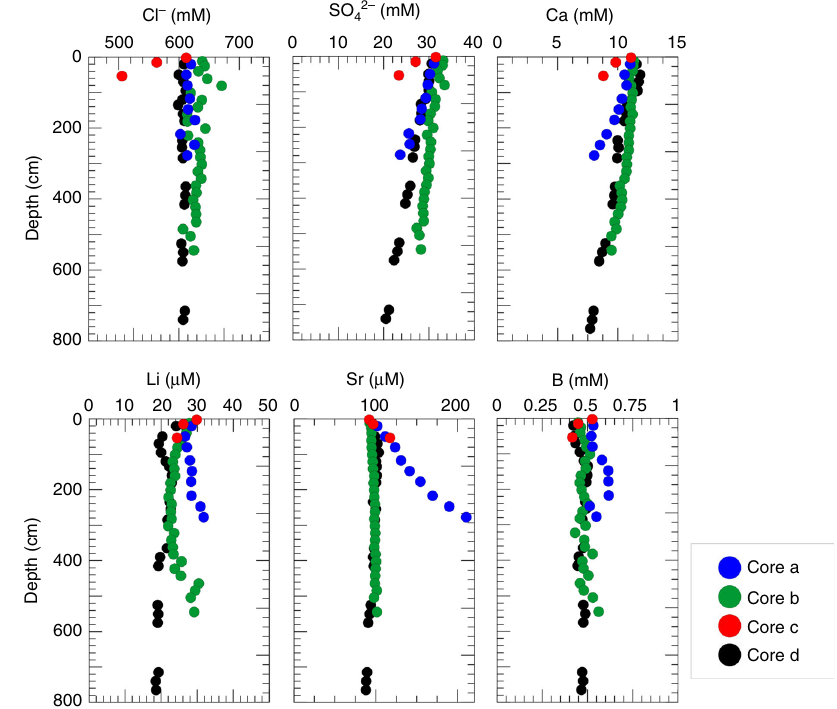
Fig. 7 Depth pro fi les of selected pore water constituents in the sediment cores. Core a: SF17-04; core b: GH15-03; core c: SF17-05; core d: CQ14-02 (reference core not affected by diapirism). Core a and c from above the diapir show deviations from normal diagenetic trends (core d). In both cores, pore water Sr concentrations increase continuously with depth; in core a, this trend is accompanied by depletion in Cl (and other elements that typically behave conservative at this depth below the sea fl oor). These geochemical anomalies provide evidence for fl uid advection (affected probably by mineral dewatering and other deep-seated geochemical processes) and suggest a direct relation to the observed diapirism. Core location in Fig.